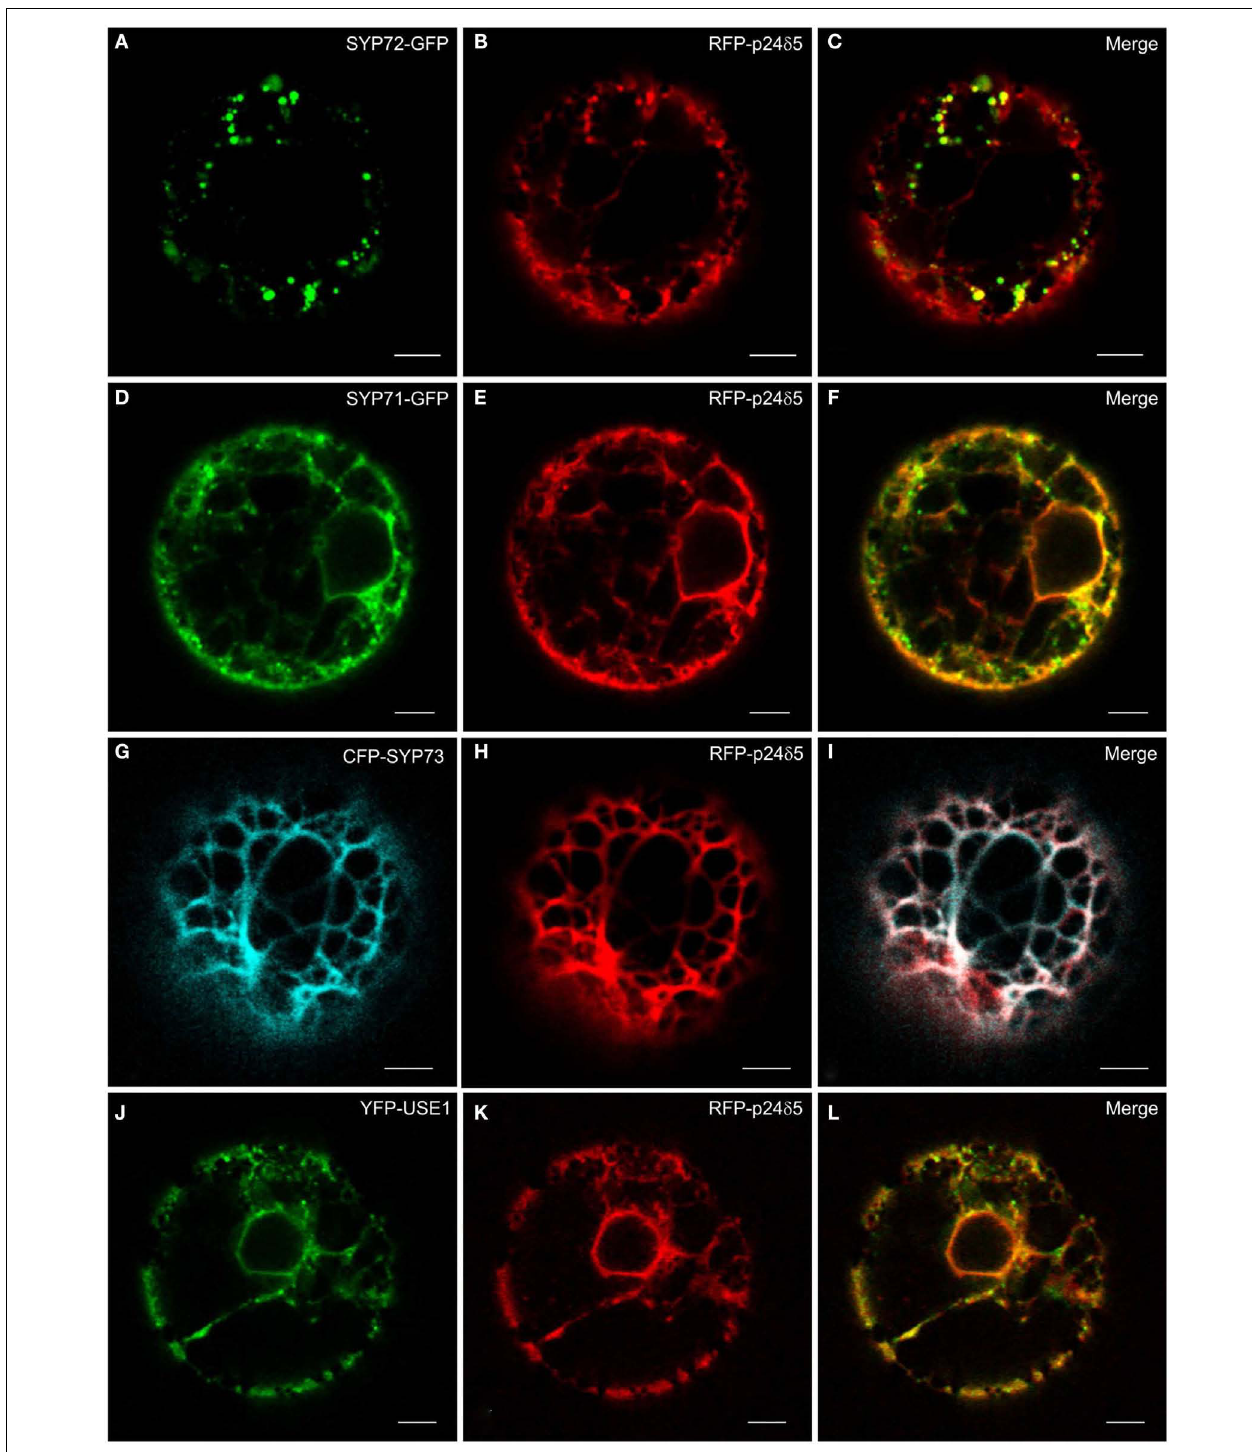
network the red RFP-p24 δ 5 signal is also present as punctae which colocalize exactly with the punctate green SYP72-GFP signals.This phenomenon was partially recognizable in the case of SYP71 and USE1 but was not at all visible with SYP73. All images are of single optical sections. Magnification bars = 5 µ